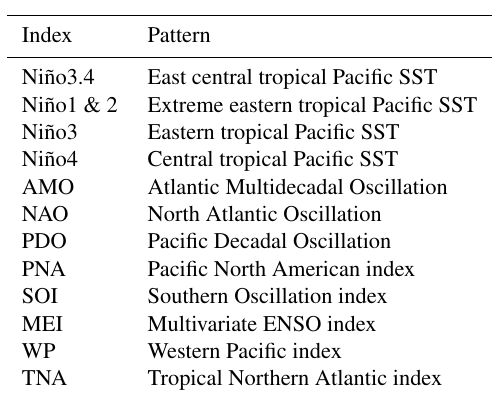
Table 2. List of climate indices included as potential